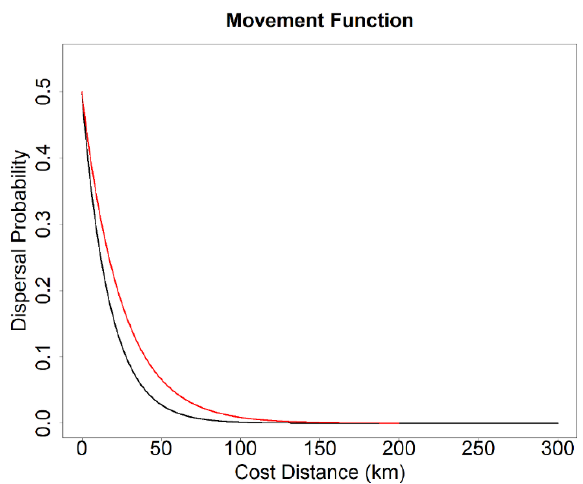
Figure 2. Functions used to transform cost distance to dispersal probability for parameterizing landscape genetics simulations. Black curve represents dispersal probability function of the high-dispersal scenario (300 km). Red curve represents dispersal probability function of the low-dispersal scenario (200 km).